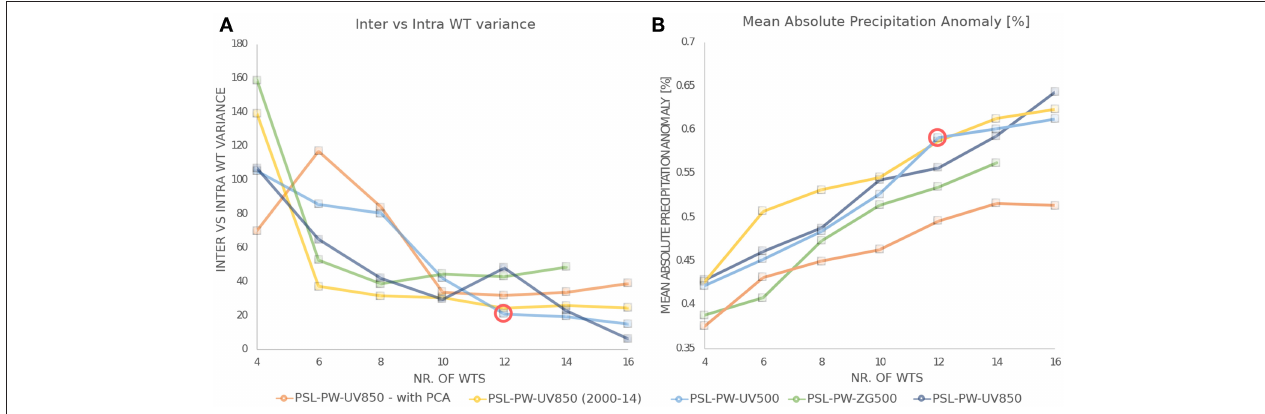
FIGURE 2 | Assessment of the clustering strength of WTs. (A) Inter- vs. intra-cluster variance and (B) absolute precipitation anomalies averaged over all WTs. Different colors show different WT settings. The tested input variables are sea level pressure (SLP), precipitable water (PW), wind speed at 850hPa/500hPa (UV850/UV500), and 500hPa geopotential height (ZG500). We also test the impacts of using a principal component analysis (PCA) before the WT clustering and the length of the clustering period, which is 1979–2014 unless otherwise denoted. The red circle shows the final WT setup using 12 WTs and SLP, PW, and UV500 as input